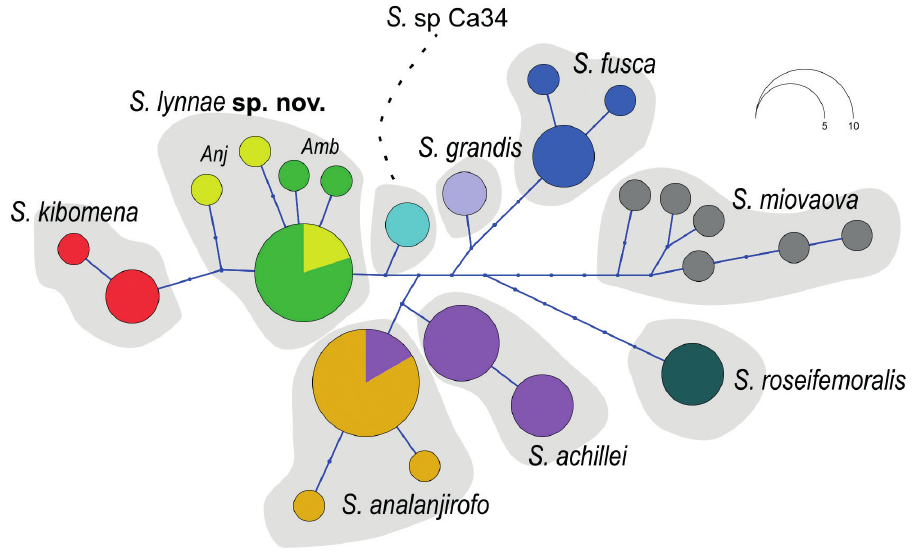
Figure 3. Haplotype network constructed from nuclear RAG-1 gene sequences (338 bp) of seven speci- mens of Stumpffia lynnae sp. nov. (two from Anjozorobe (Anj; yellow) and five from Ambohitantely (Amb; green)) and eight other closely related Stumpffia species from Clade C2 (Rakotoarison et al. 2017). Small dots represent mutational